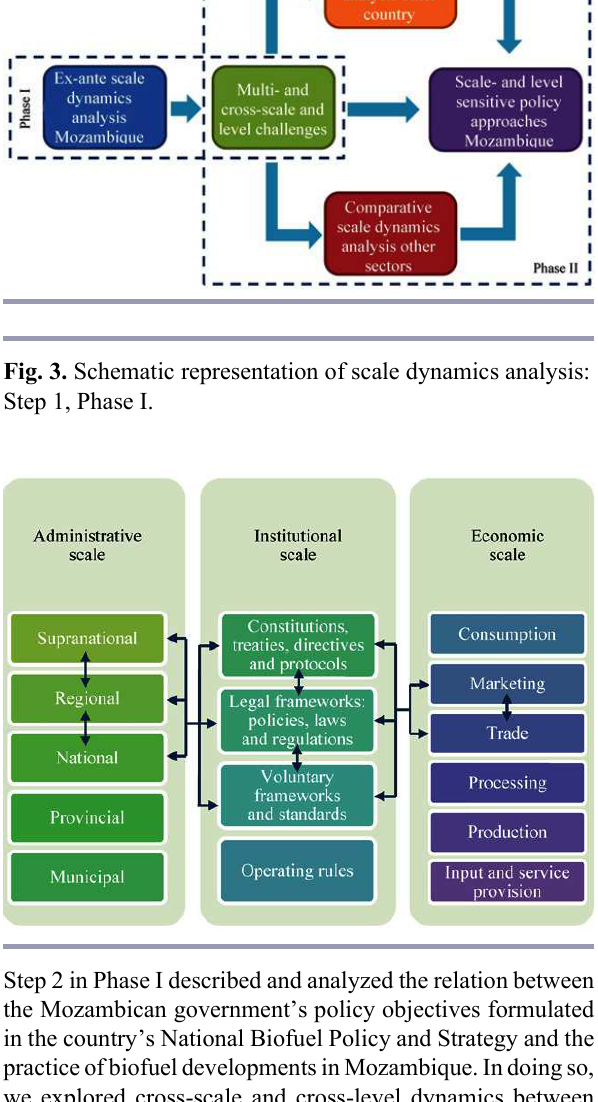
Fig. 4. Schematic representation of scale dynamics analysis: Step 2, Phase